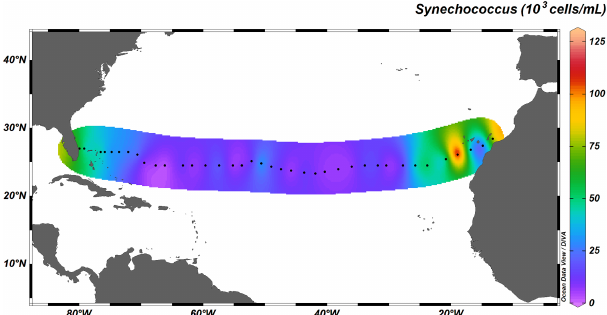
Figure 7. Depth-integrated abundance of Synechococcus (in 10 3 cellsmL − 1 ) above MLD. Black dots represent the 38 out of the total 135 stations sampled for cyanobacterial